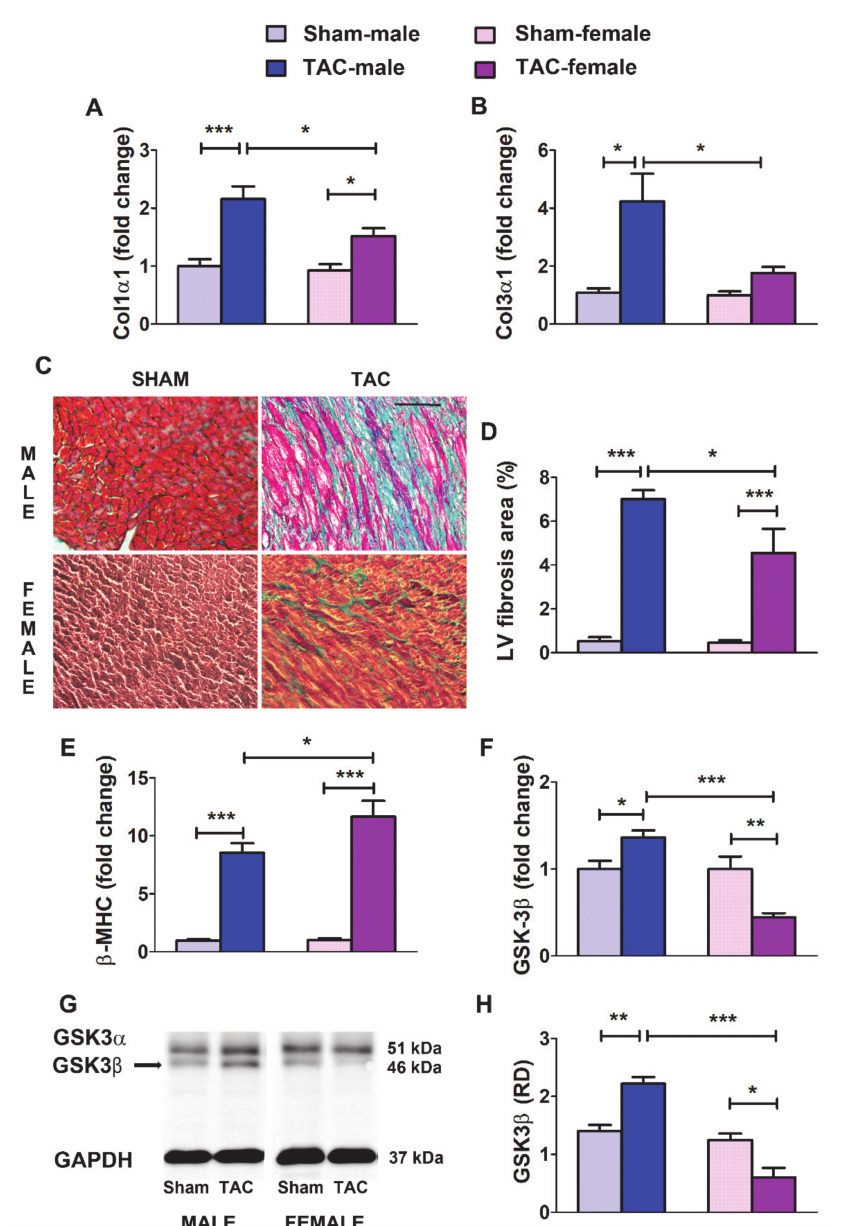
Figure 5. Regulation by pressure overload of relevant LV remodeling related elements in mice. A and B : Fold change in mRNA levels of Col1 α 1 ( A ) and Col1 α 3 ( B ) in the LV from male and female mice subjected to sham surgery or transverse aortic constriction (TAC) for 4 weeks (sham males, n = 9; sham females, n = 11; TAC males, n = 15; TAC females, n = 12). ( C ) Representative images of LV sections showing myocardium stained with Masson’s trichrome. With this technique, muscle fibers are stained red, fibrosis is stained blue, the cytoplasm is stained light red or pink, and cell nuclei are stained dark brown to black. ( D ) Average fractional LV area of fibrosis in 4 sections from three to six mice per group. ( E,F ) Fold change in mRNA levels of β -MHC ( E ) and GSK-3 β ( F ) in the LV from sham and TAC mice of both sexes. ( G ) Representative western blot images showing the protein levels of GSK-3 β in the LV. ( H ) Average relative optical density (RD vs. GAPDH) quantified in three mice per group in two di ff erent experiments. Data are means ± SEM. * p < 0.05, ** p < 0.01; *** p < 0.001 (ANOVA followed by the Bonferroni post-hoc